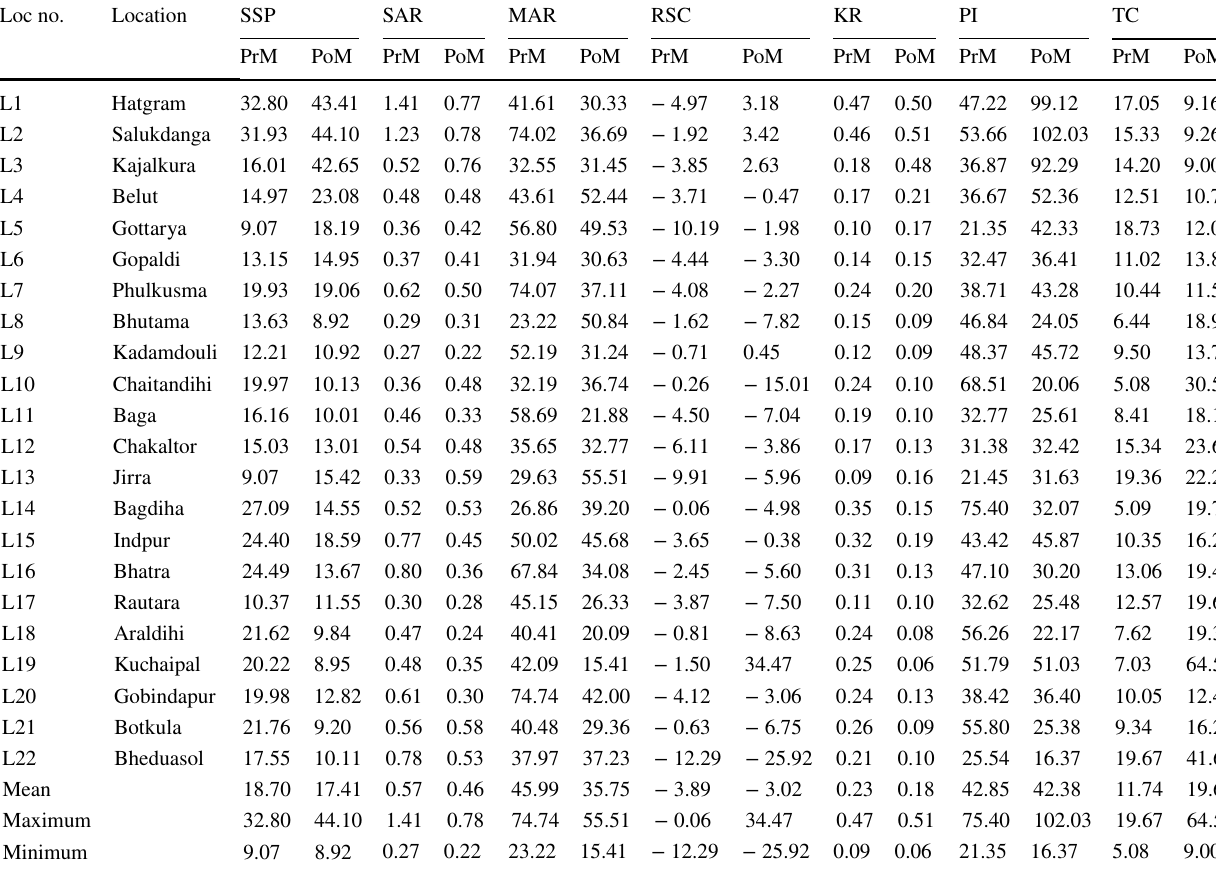
Table 5 Values of estimated water quality parameters/indices for pre-monsoon and post-monsoon seasons Loc